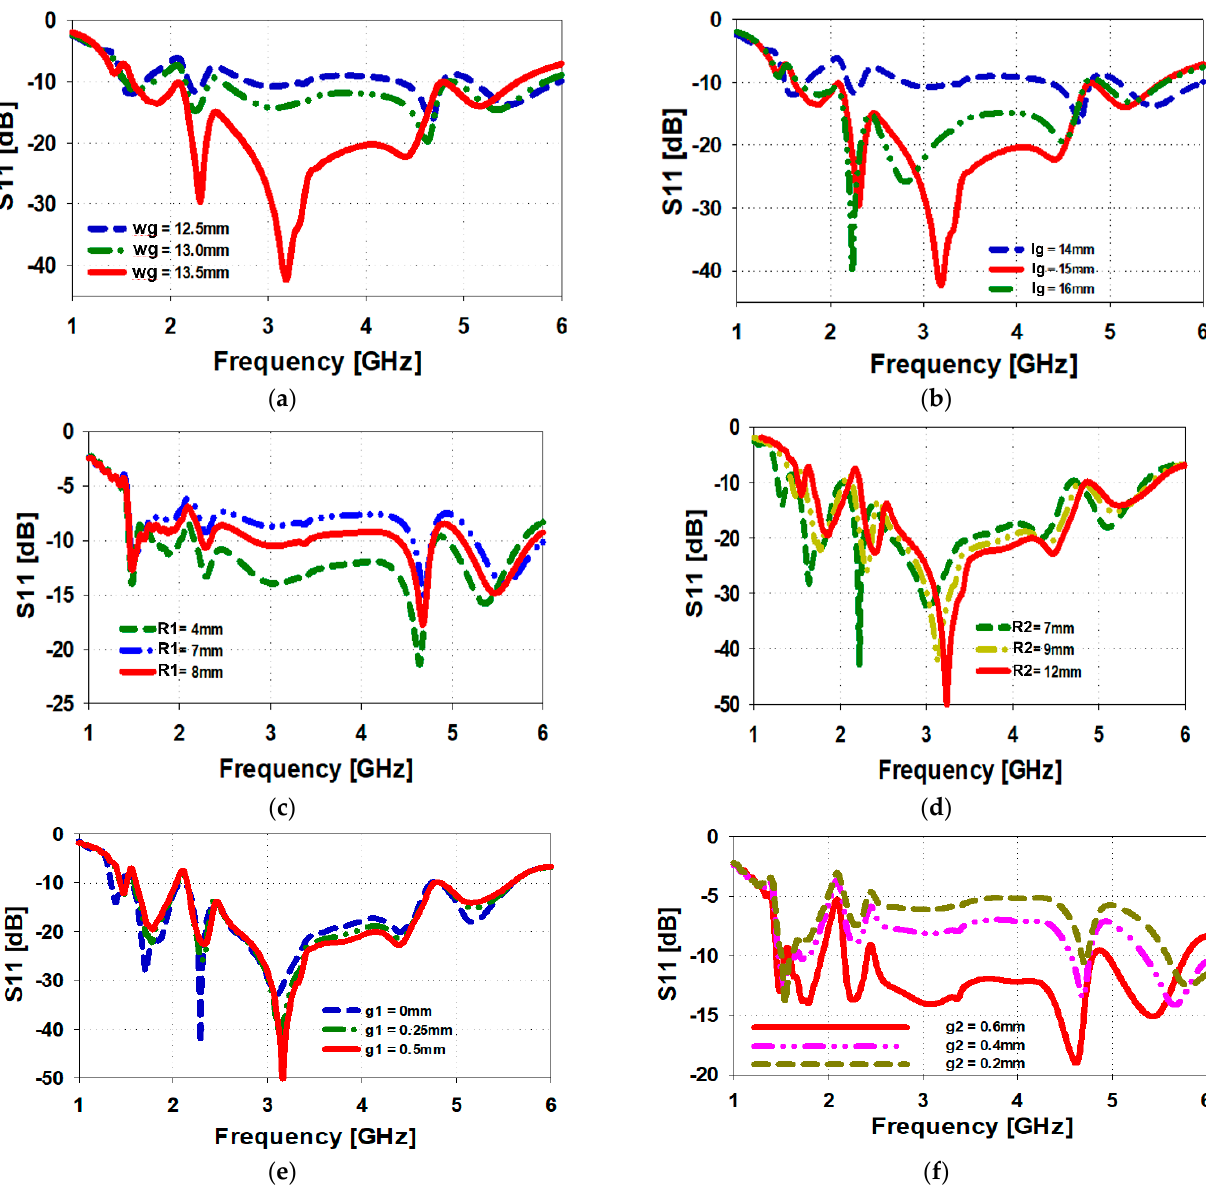
Figure 4. ( a ) Effect of variation in “wg” on S11, ( b ) effect of variation in “Ig” on S11, ( c ) effect of variation in “R1” on S11, ( d ) effect of variation in “R2” on S11, ( e ) effect of variation in “g1” on S11, and ( f ) effect of variation in “g2” on